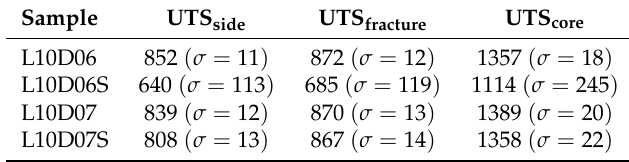
Table 3. Mean ultimate tensile strength (UTS) of the as-built test samples in